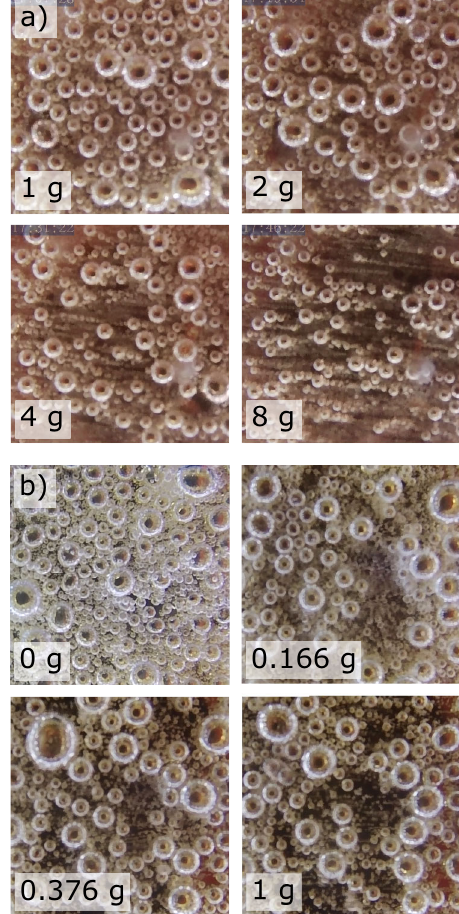
Fig. 4 Bubble behavior in various gravity levels. A comparison of 1 cm 2 frames of the bubbles on the electrode surface ( t = 14 s) collected at 50 mA cm – 2 in: a laboratory conditions using a centrifuge to generate 1 – 8 g, and b parabolic fl ight using a centrifuge to generate 0.166 – 1 g.